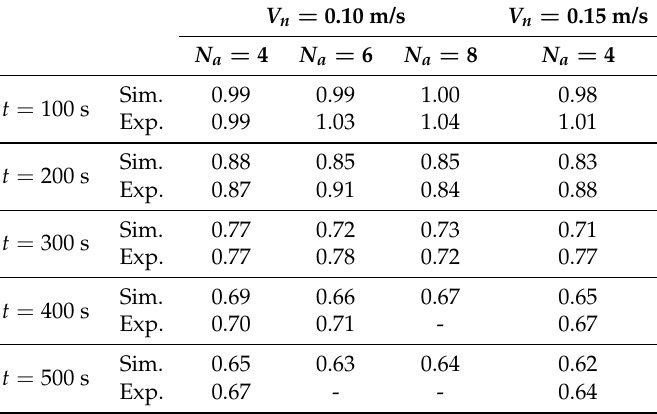
Table 4. Comparison of the efficiencies registered in simulations and experiments, obtained from Figure 5a,b and Figure 12a,b. Sim. indicates simulation and Exp. experiment. The values outside the brackets are the mean values, whereas the values inside them are the interval of maximum and minimum efficiencies found. Note that for some experiments, no interval or even no data is available because of the limited duration of the batteries. V n = 0.10